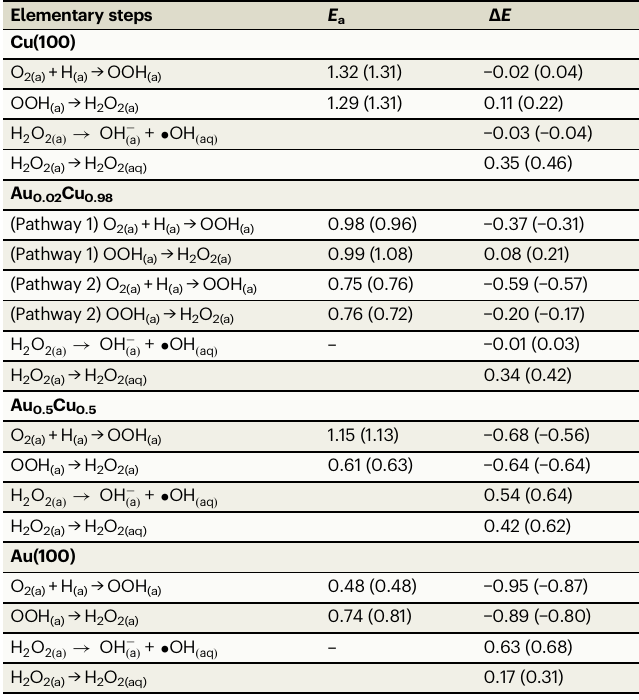
Table 2 | Calculated reaction barriers ( E a in eV) and reaction energies ( Δ E in eV) for elementary reactions of O 2